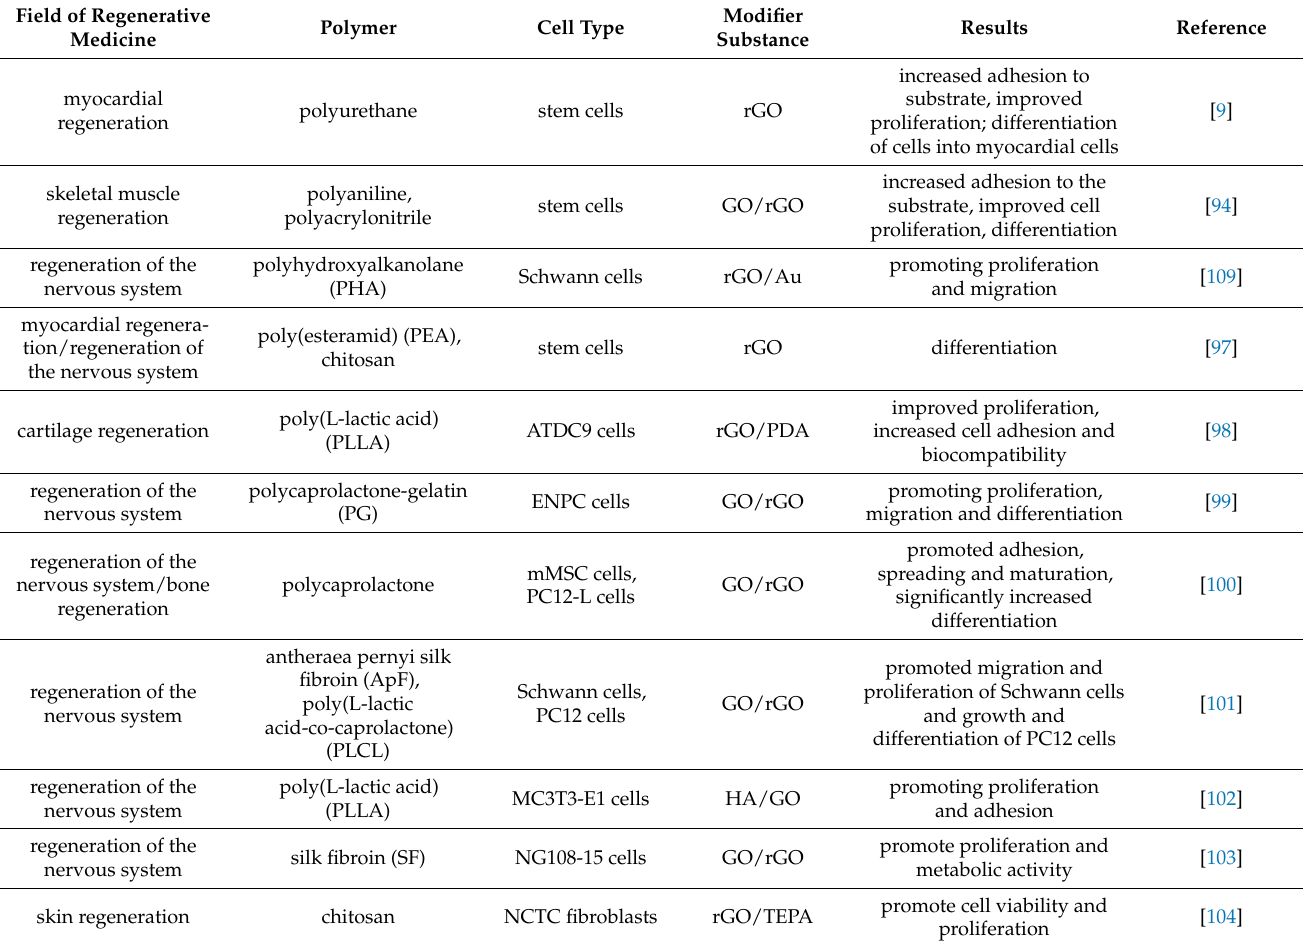
Table 2. GO and rGO functionality related with the regeneration of different